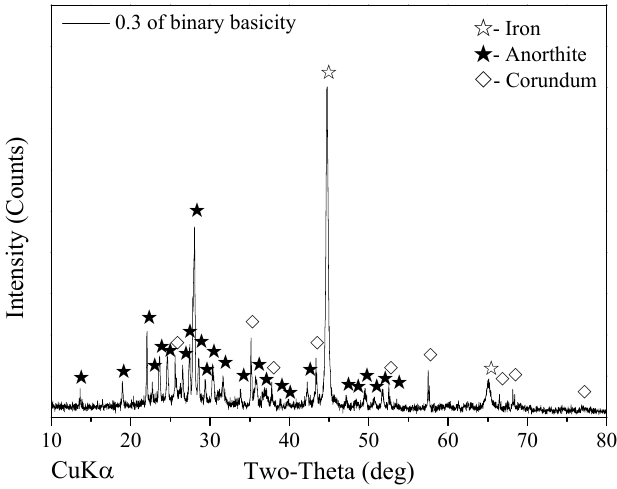
Figure 13. Main minerals in reduced pellets with a binary basicity of 0.3 detected by XRD.